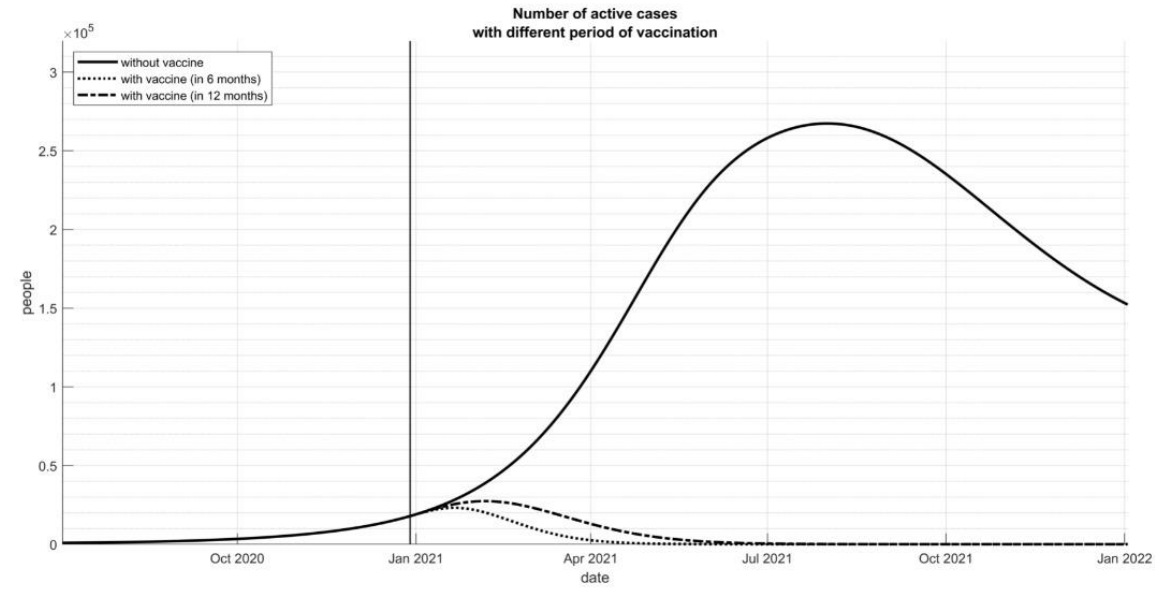
Figure 2. Number of active cases with different period of vaccination.